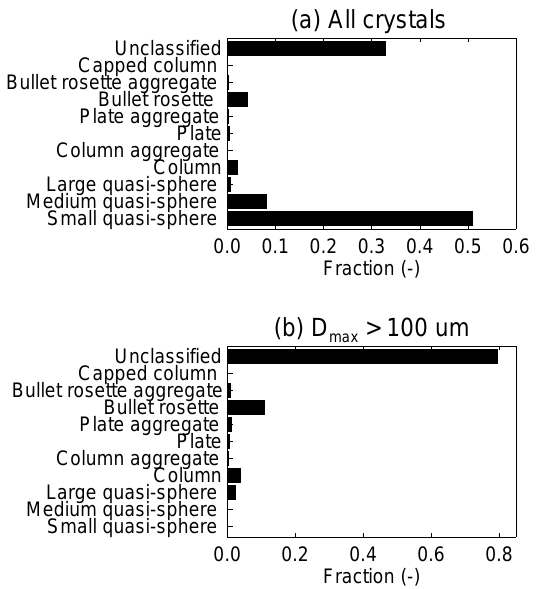
Figure 2. Fraction of ice by habit class for all crystals imaged (a) and for those with D max greater than 100µm (b)